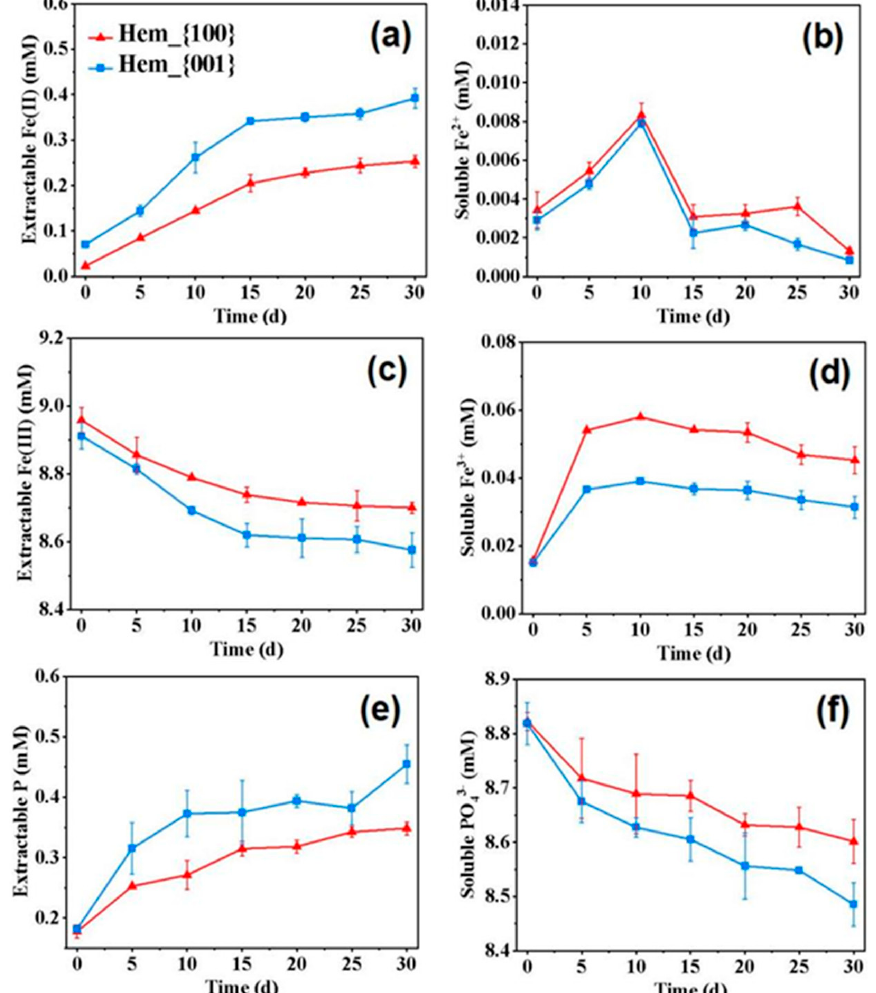
Figure 3. Variation of the ( a ) soluble Fe 2+ content, ( b ) solid Fe(II) content, ( c ) soluble Fe 3+ content, ( d ) solid Fe(III) content, ( e ) PO 4 3+ content, and ( f ) solid P content in hematite systems. Data correspond to an average of biological triplicates, and the error bars indicate standard deviations. Experimental conditions: hydrophosphate − buffered (9 mM); Geobacter sulfurreducens (OD 600 ≈ 0.30); iron oxide nanocrystals (9 mM).